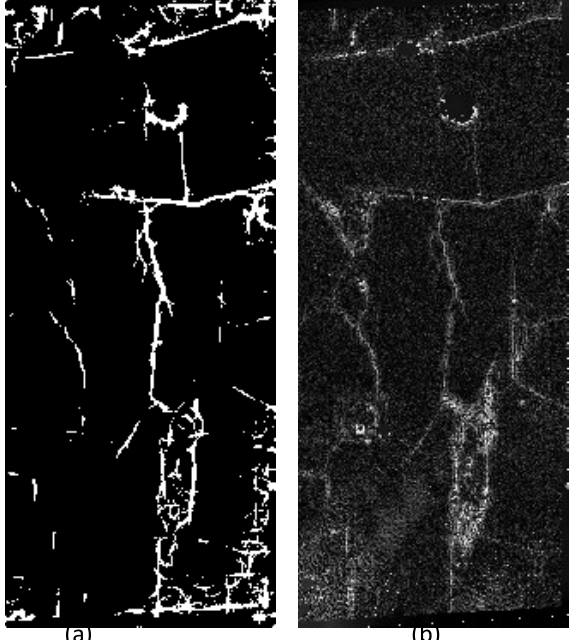
Figure 10. Results of a sample of alligator cracks: (a) detected results containing the alligator cracks, (b) the corresponding DTM high-pass convolution